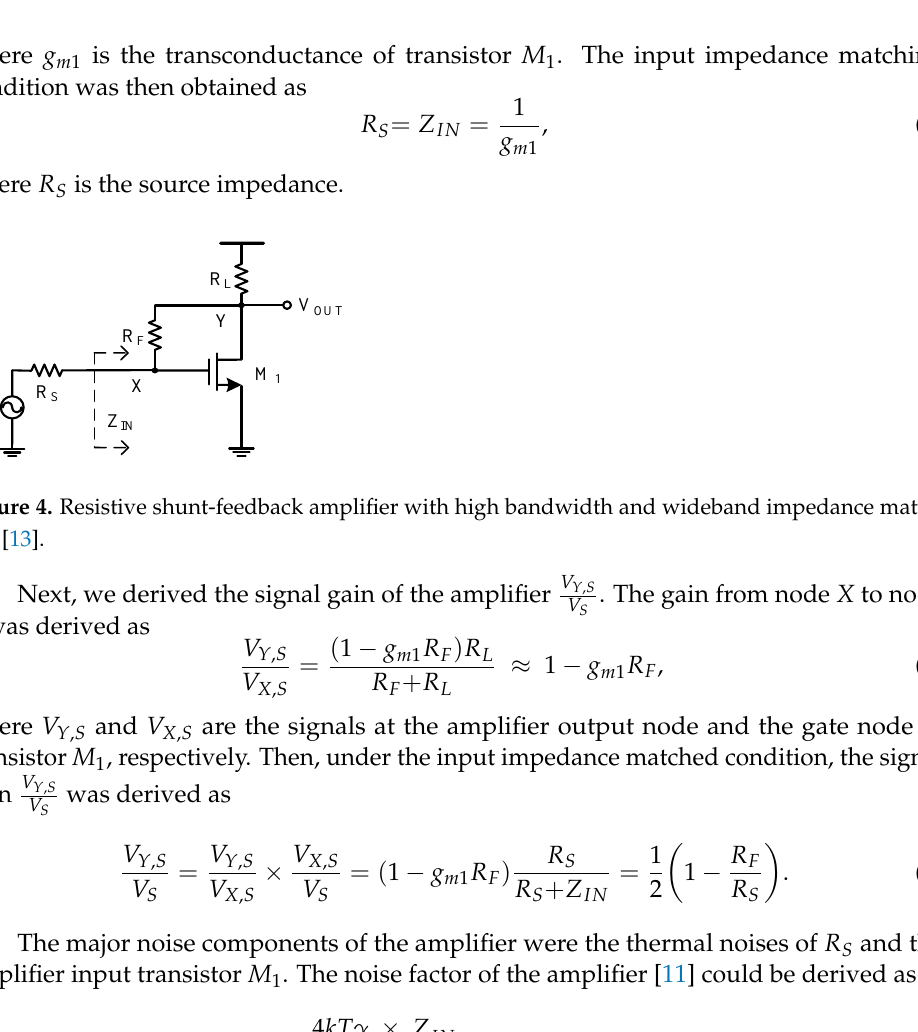
5 of 18 Figure 3. ( a ) Measurement setup for the PA response of the PVDF transducer; ( b ) recorded PA signal induced by laser pulse onto black tape. Given that the typical resonance frequency of the PVDF transducer was about 50~80 MHz where the corresponding R s , as shown in Figure 2, was about 50 ± 10 Ω and that the typical transducer output signal was 1 mV, as shown in Figure 3(b), the LNA along with the post amplifier was thus designed to aim to achieve about 40 dB voltage gain, −5 0 dBc THD under 1 mV input, and a better than −1 5 dB input return loss across the transducer resonance frequency range. 3. LNA Design and Analysis 3.1. Resistive Shunt-Feedback The resistive shunt-feedback amplifier, as depicted in Figure 4, was chosen as the basic building block for the proposed high-frequency LNA. The resistive shunt-feedback structure simultaneously offered a high f -3dB bandwidth and wideband impedance match- ing. Neglecting the effect of parasitic capacitance C gs of the input transistor M 1 and as- suming R L ≫ R F , the input impedance of the shunt-feedback amplifier could be derived as Z IN = R F + R L 1 + g m1 R L ≈ 1 g m1 , (1) where g m1 is the transconductance of transistor M 1 . The input impedance matching con- dition was then obtained as R S = Z IN = 1 g m1 ,